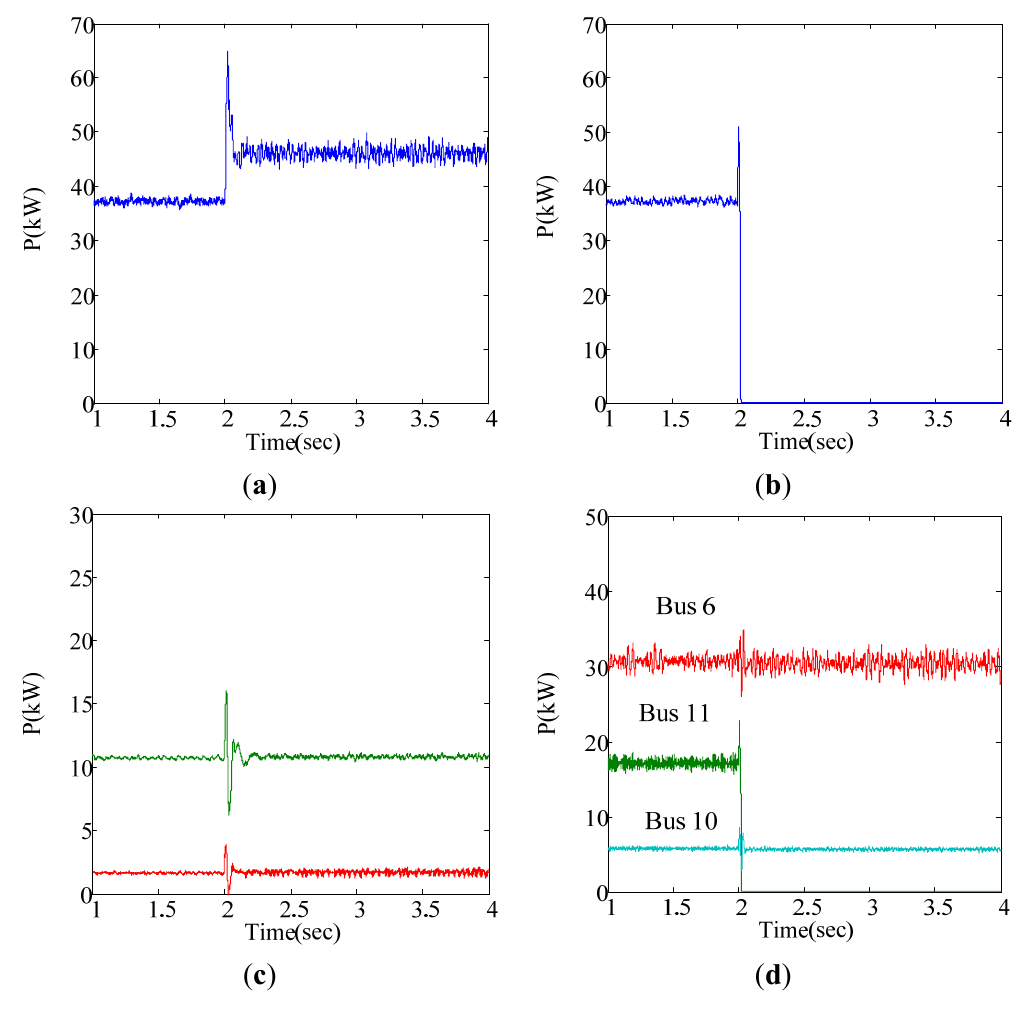
Figure 7. System responses caused by fault at Bus 4: ( a ) kW of gas-turbine at Bus 11; ( b ) kW of gas-turbine at Bus 5; ( c ) wind power generations; ( d ) PV generations; ( e ) voltage at Bus 3; and ( f ) frequency at Bus